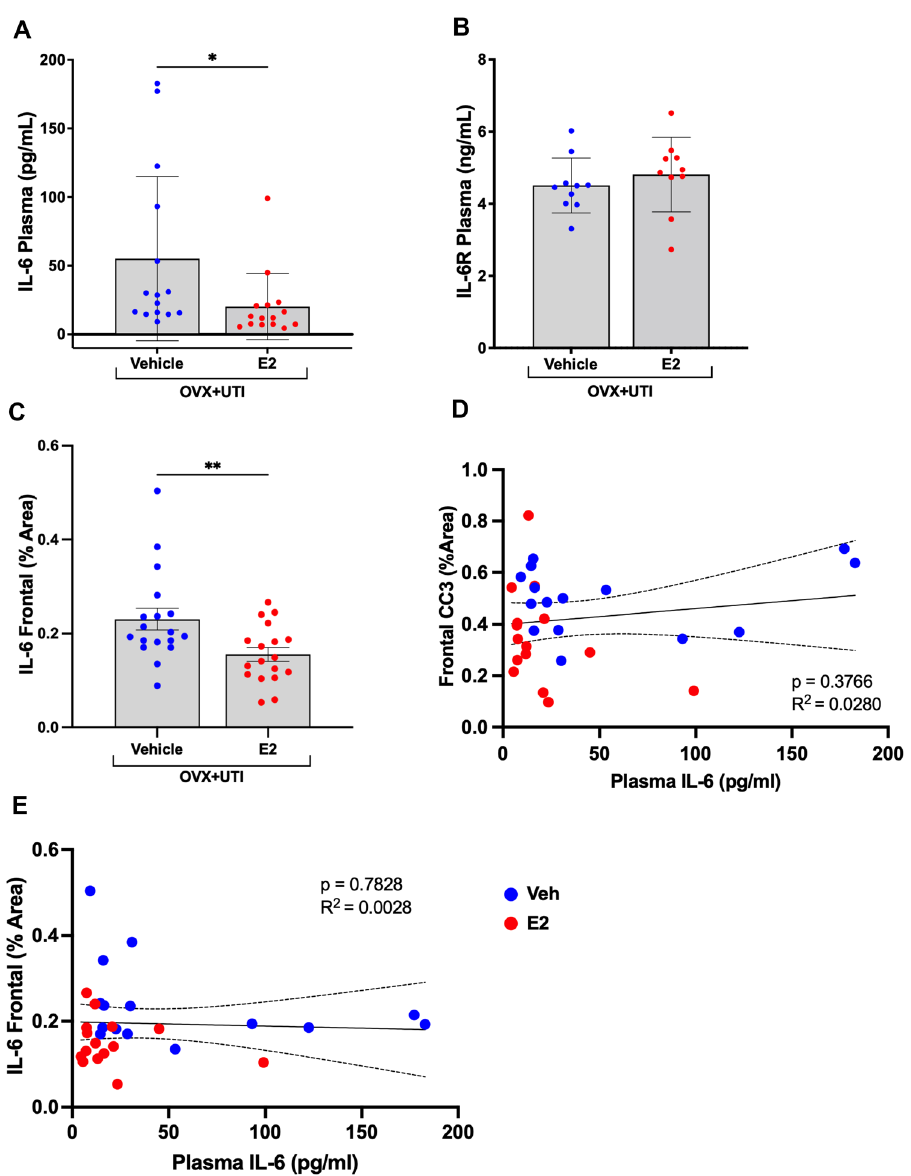
Figure 5. 17β-estradiol (E2) attenuates plasma and frontal cortex concentrations of IL-6 but not soluble IL-6 receptor alpha (sIL-6R). ( A – C ) Among ovariectomized and UTI inoculated mice (OVX + UTI), individuals treated with E2 (7 µg) have significantly lower IL-6 plasma concentrations in the plasma and frontal cortex with no significant change in sIL-6R concentrations as measured via ELISA. Plasma samples (n = 15) could reliably be obtained from all but 3 vehicle and 2 E2 animals. For ( B ), plasma IL-6R was measured in a randomly chosen subset of animals (n = 10/group) to confirm differences in delirium-like phenotypes were not driven by receptor density. For ( A ), a single statistical outlier was identified and removed from the E2 group – the abnormally high value may have resulted from hemolysis of the sample. Exclusion of the data point yielded p = 0.0495 (t = 2.102, df = 18.45), while inclusion resulted in p = 0.1654 (t = 1.430, df = 24.66) (Fig. S7). ( D , E ) Regression analyses of plasma IL-6 (pg/ml) on cleaved caspase-3 (CC3) and IL-6 levels in the frontal cortex. Dotted lines represent 95% confidence intervals. Group size was n = 10–18. Data are expressed as mean ± SD. *p < 0.05, **p <